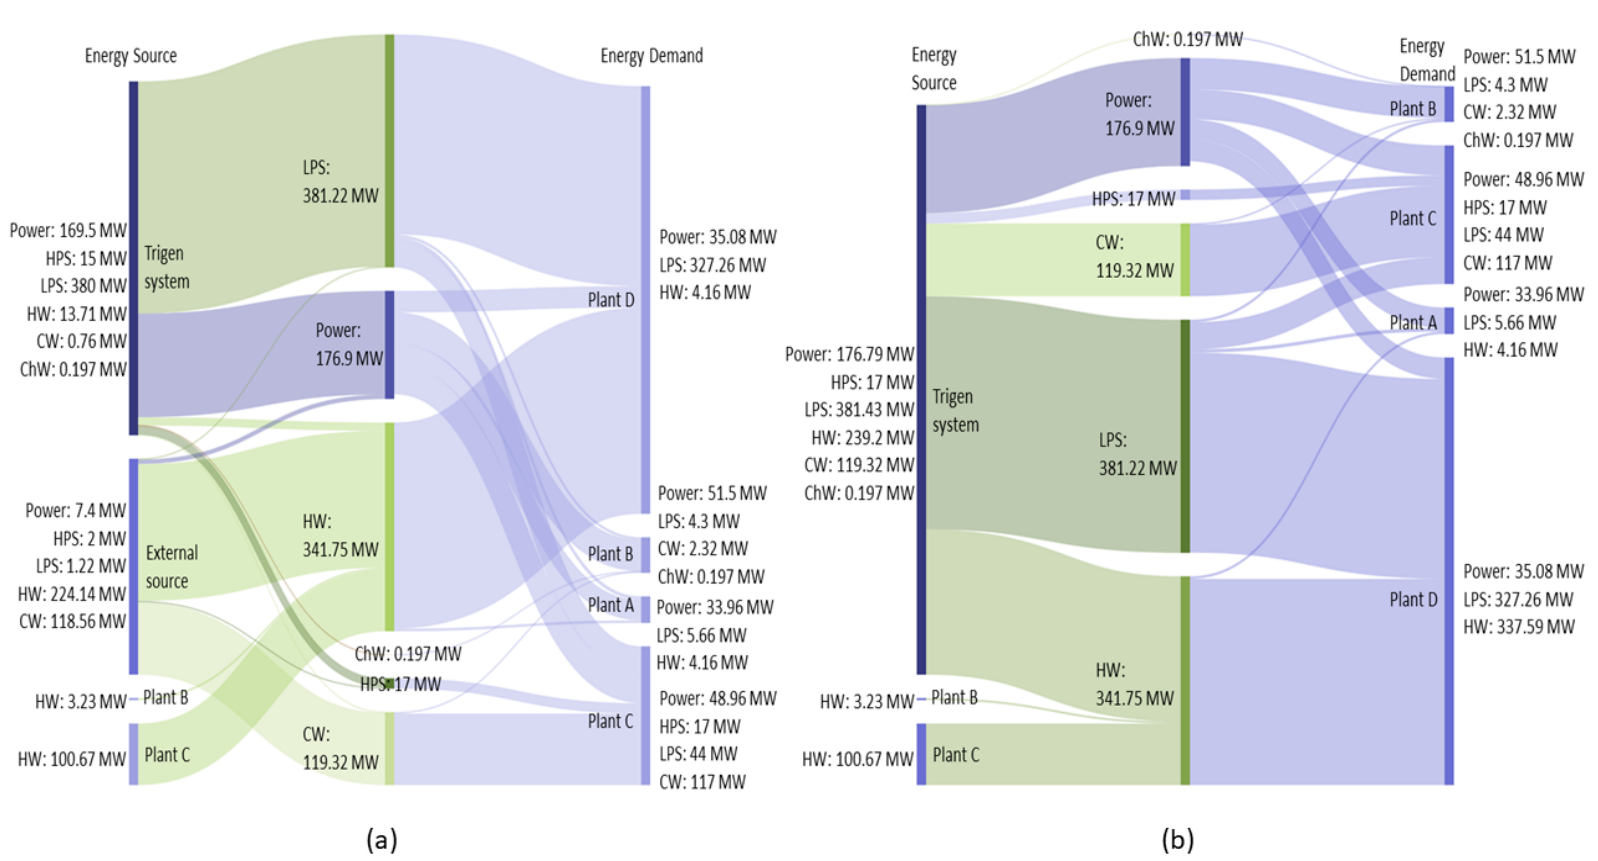
Figure 7. Graphical TriGenSCA ( a ) before, and ( b ) after iterations.